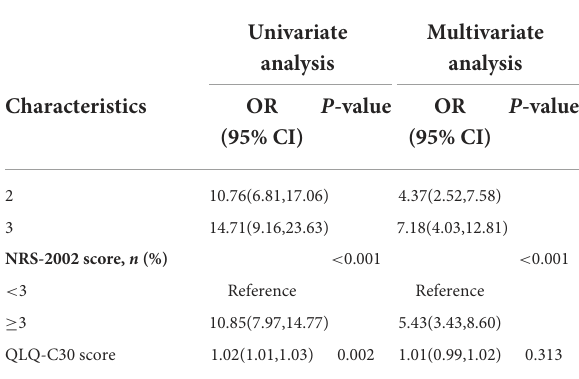
TABLE 2 Univariate and multivariate logistic regression analyses of the risk factors associated with low SMD in the training cohort a .